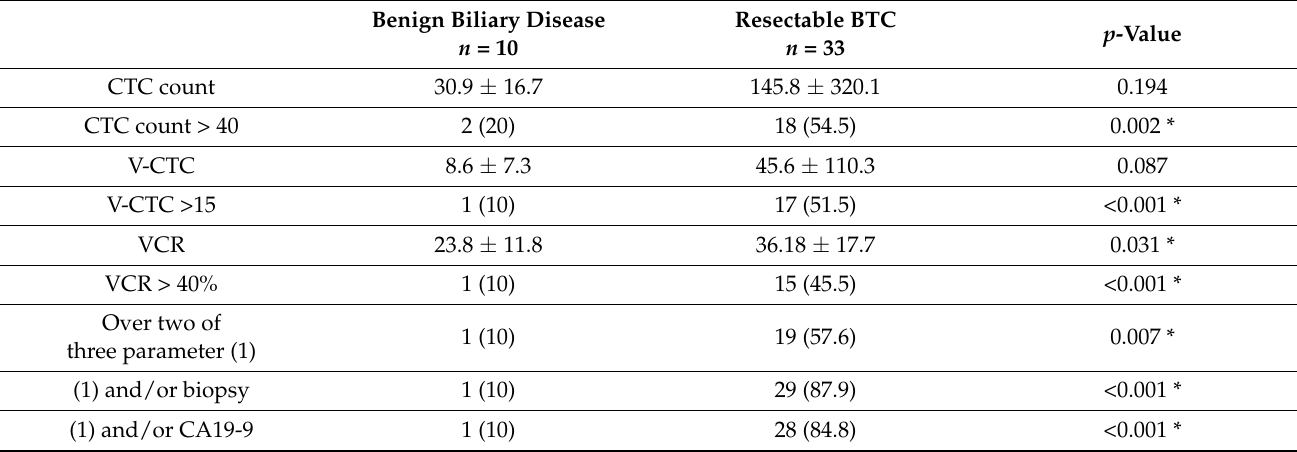
Table 3. CTC count and sensitivity and specificity of each parameter between benign and resectable biliary tract